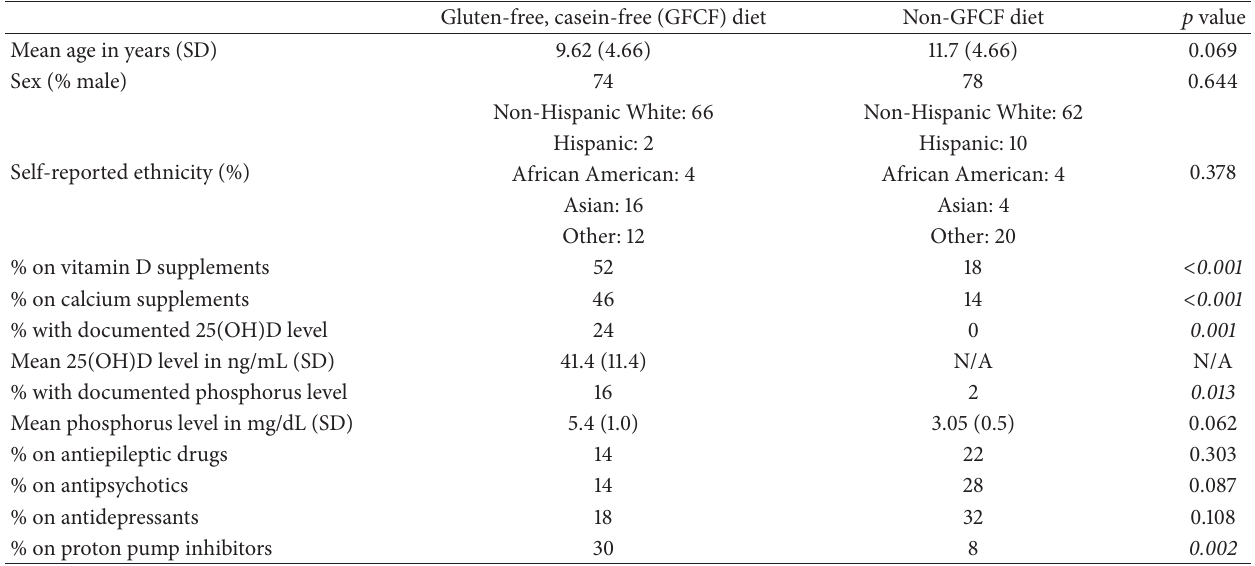
Table 1: Clinical characteristics of children on the GFCF diet versus those not on a GFCF diet.